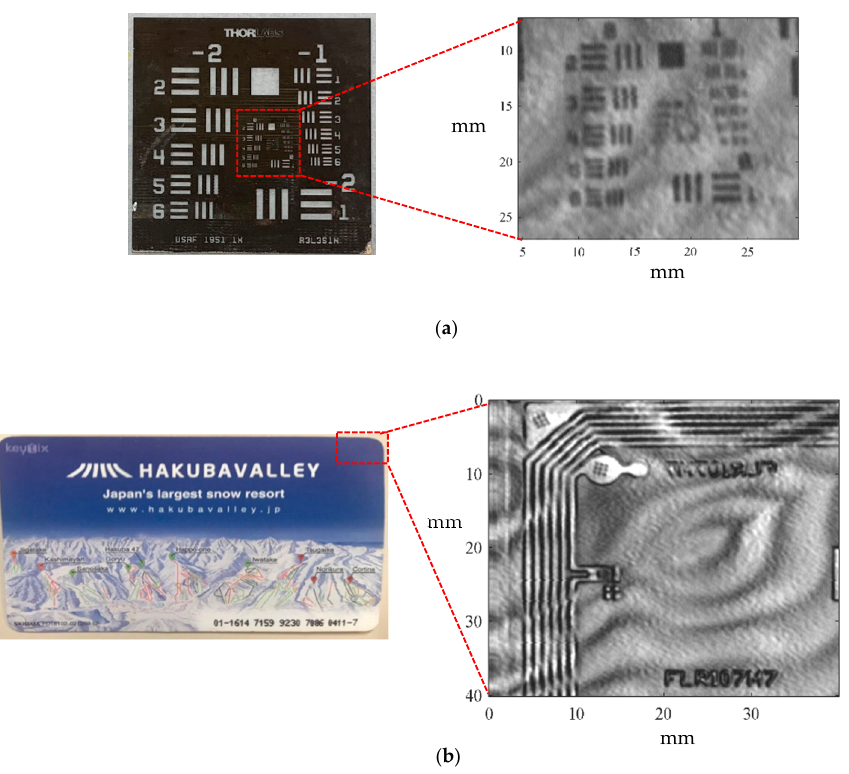
Figure 17. Imaging results at 0.957 THz: ( a ) Imaging of test target without paper; ( b ); ( b ) Imaging results of an IC card.